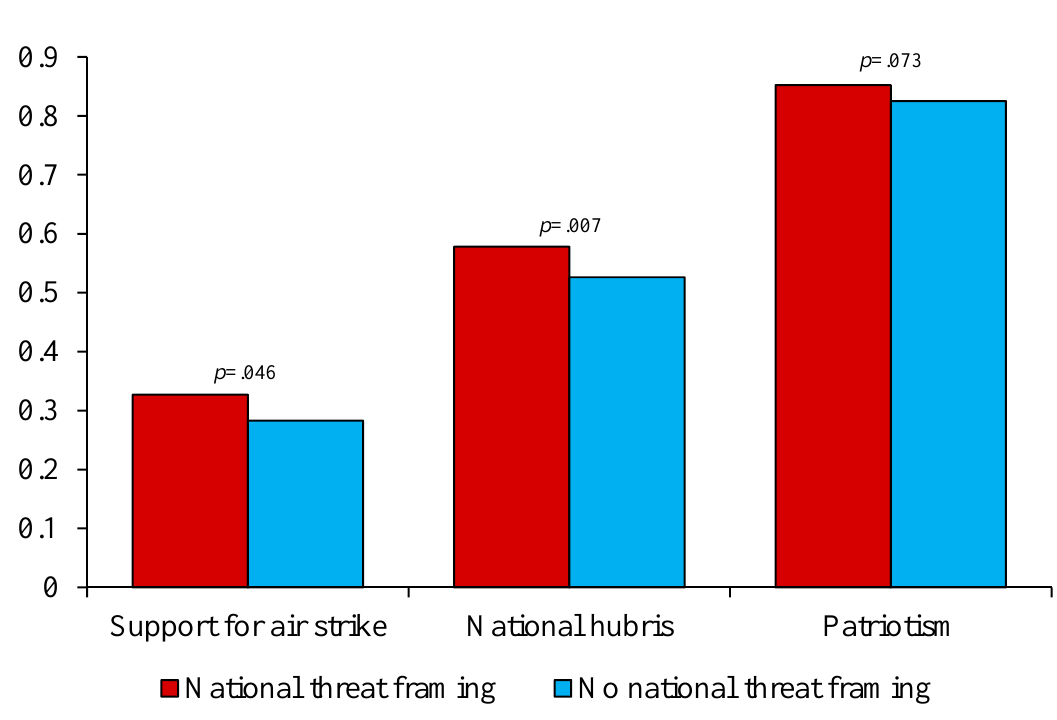
Figure 1: Effects of national threat framing on outcome scales ( N = 558). p -Values are for the differences in means, based on independent samples t